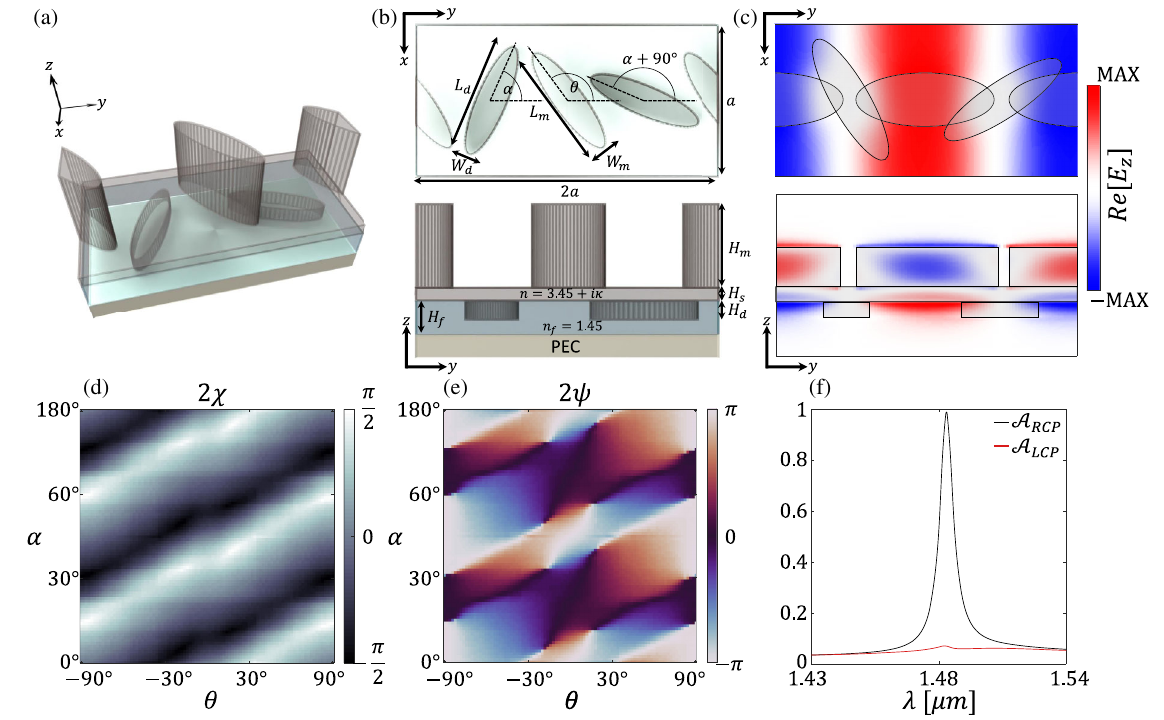
FIG. 6. Metaunit library of a thermal metasurface. (a) Perspective view of a structured silicon film sitting atop a PEC with a dielectric filler in between. The top silicon elliptical pillars are monomers, and the bottom are dimers. (b) Top and side views of the unit cell in (a), defining the geometric and material parameters. (c) Cross sections of an example quasi-BIC supported by this structure and controlled by the dimer. (d),(e) The latitude and longitude on the Poincar´e sphere of the quasi-BIC in (c) of the absorbed polarization state as the geometric parameters θ and α are varied. (f) Circularly dichroic absorption spectra for the geometry depicted in